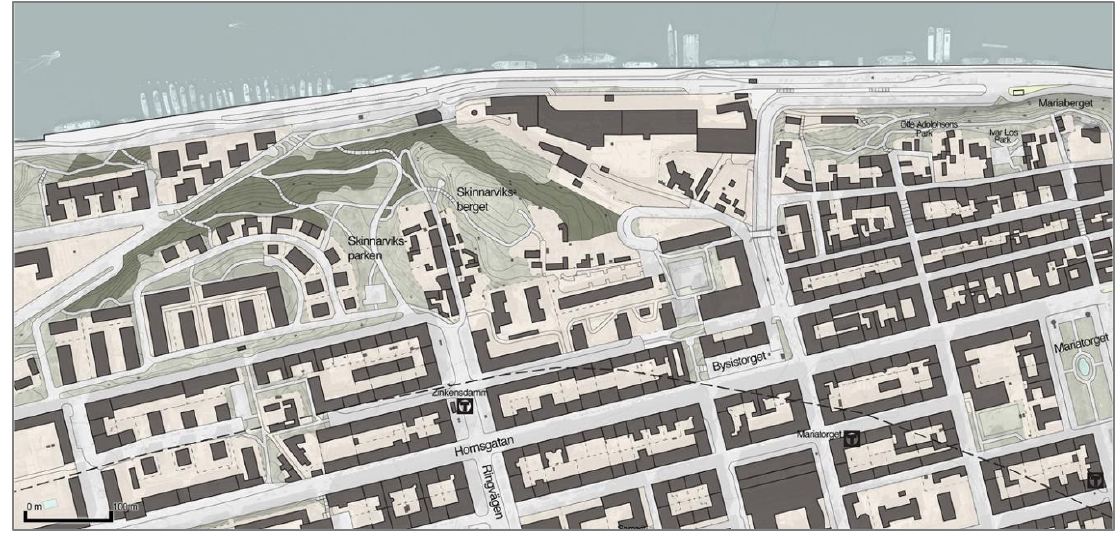
Figure 4 Skinnarviksparken and surrounding context. The distance to Hornsgatan is 222 m / 205 m (211 m to intersection) / 2 turns (+1 for Hornsgatan direction); distance to nearest subway station is 190 m / 176 m / 3 turns (+1 to enter, -1 to reach t he “side of the entrance building”); distance to Bysistorget is 513 m / 417 m / 4 turns (including entering Bysistorget, 5 turns shortest metric path) ; distance to Mariatorget is 1010 m / 816.5 m / 4 turns (including entering